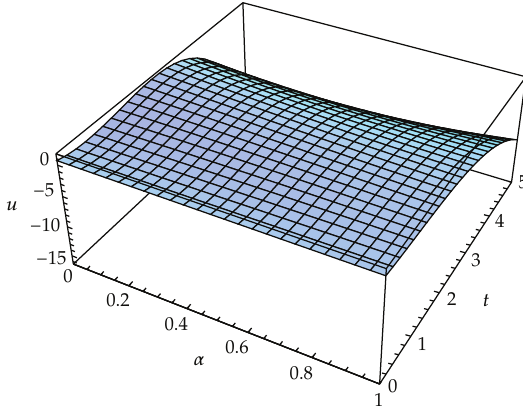
Figure 1: The surface of third-order approximate solution u (cid:2) x,t (cid:3) of (cid:2) 3.8 (cid:3) and (cid:2) 3.9 (cid:3) when x (cid:9) 0 . 8.